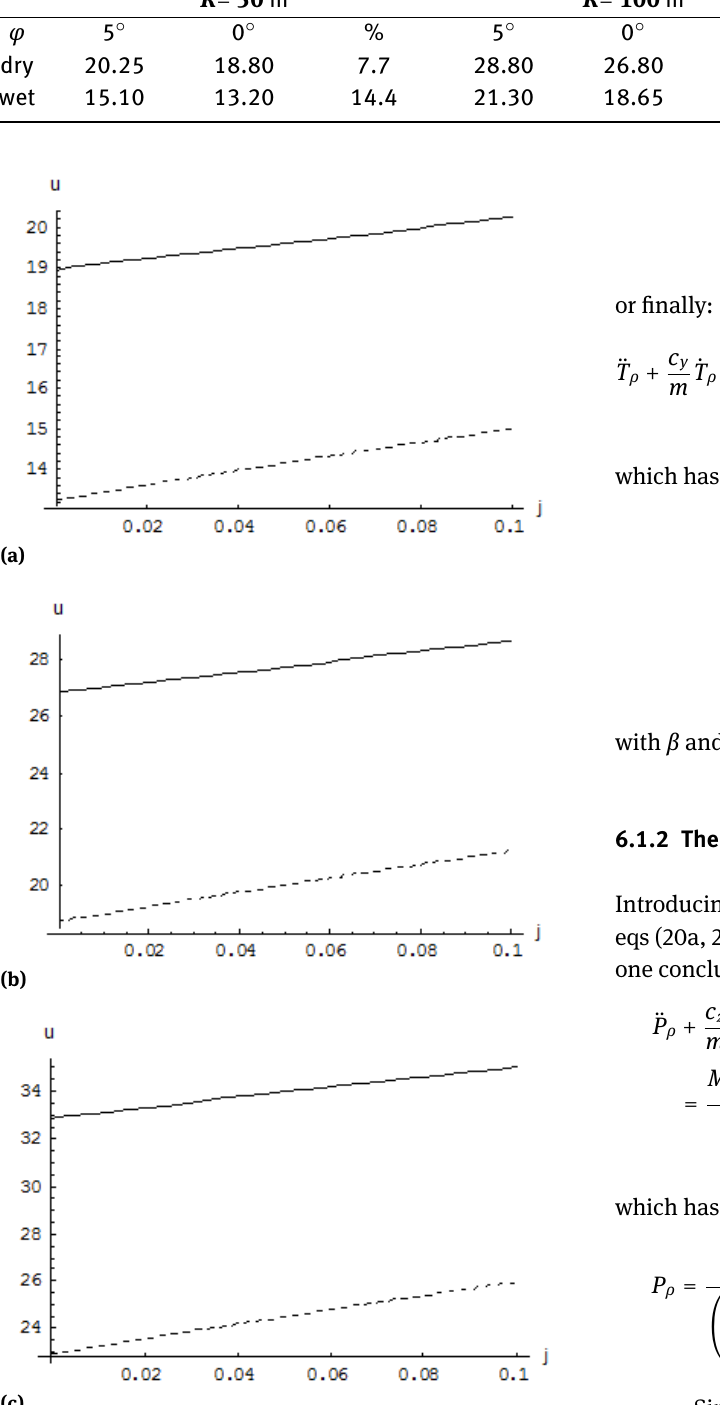
Table 1: Maximum speeds for various R , φ and deck surface conditions. R = 50 m R = 100 m